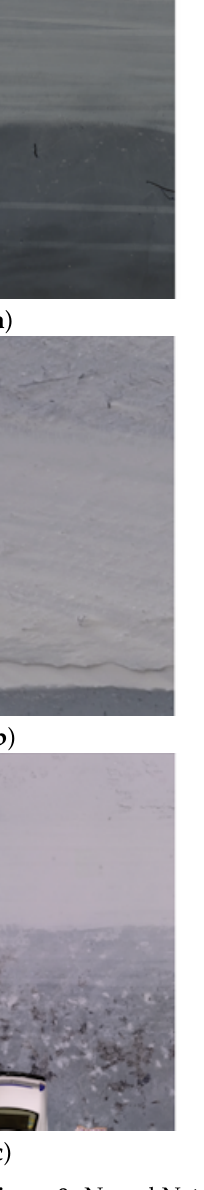
Figure 8. Neural Network Predicted Wet/Dry Shoreline Results. The left column images are the original image, the middle column images are ground-truth, and the right column images are the modified HED model prediction. ( a – c ) are samples of the AI